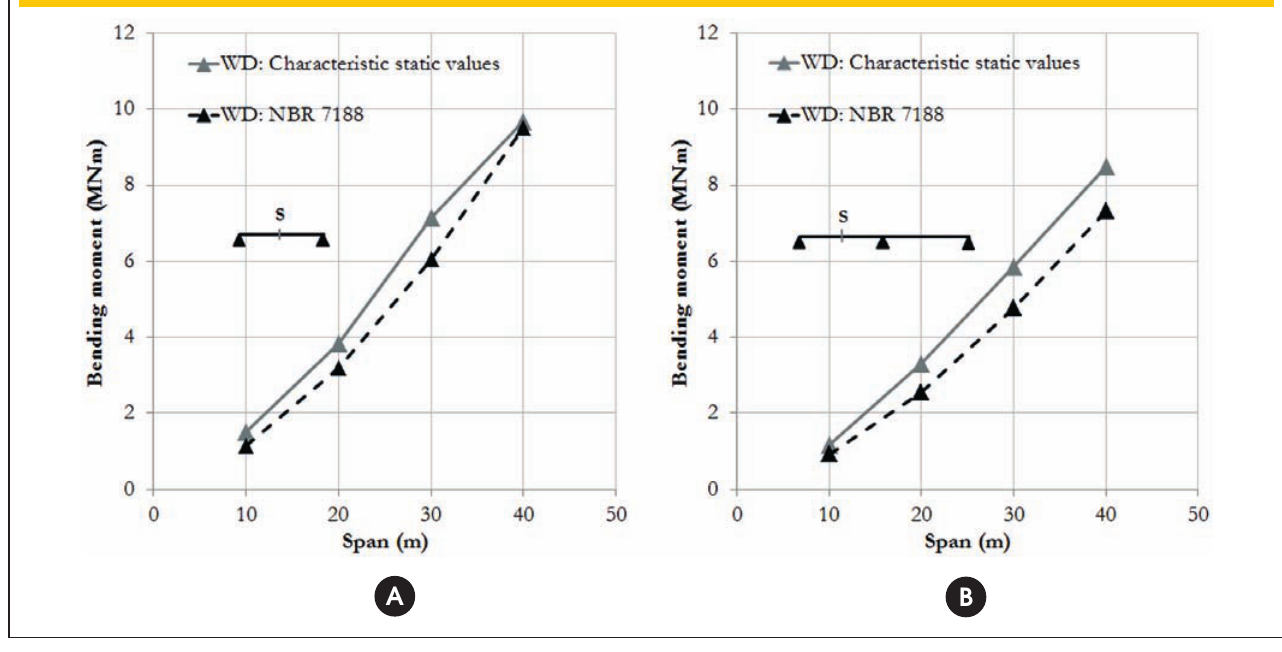
Figures 15 – Comparison in terms of static positive bending moment between the extreme values produced by the real traffic and those generated by NBR 7188 Brazilian code load